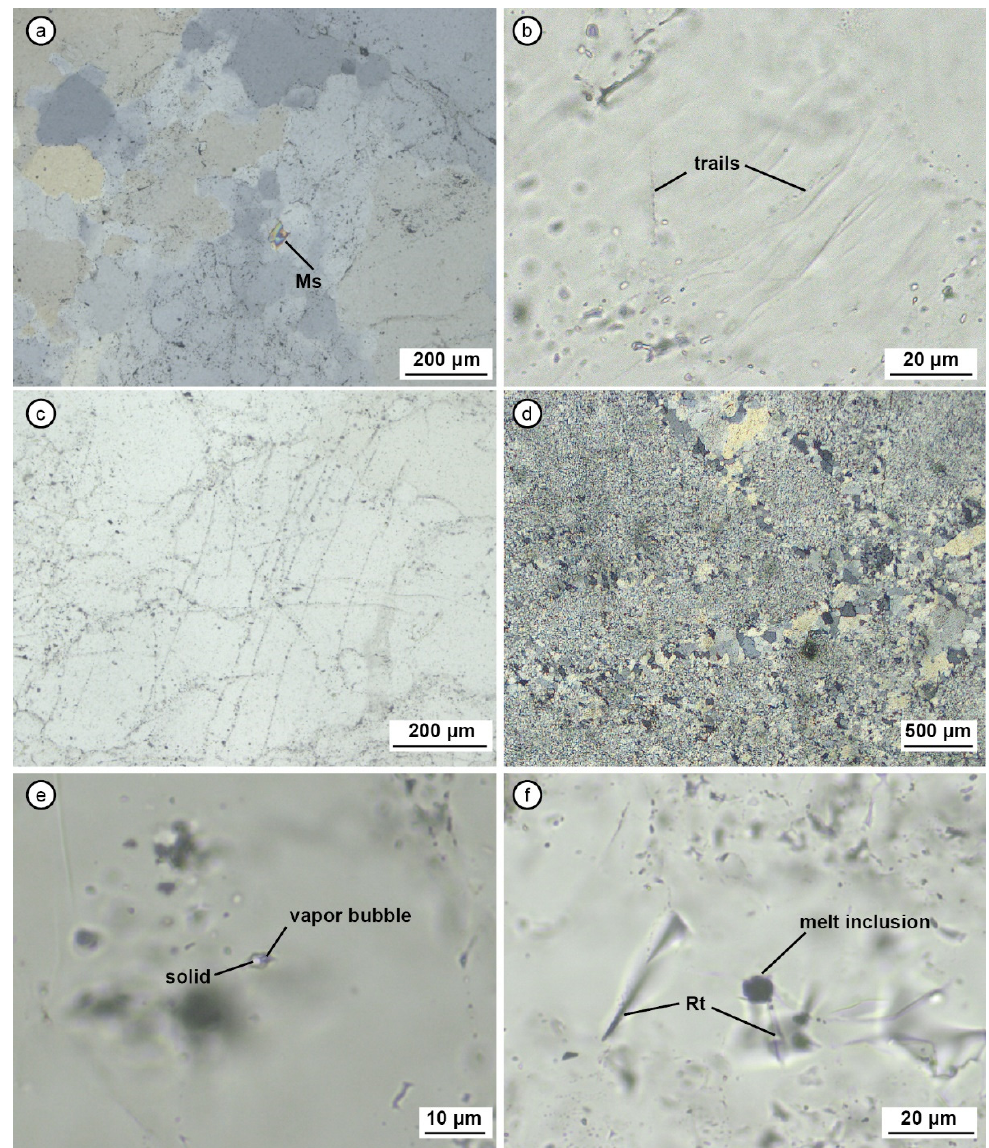
Figure 4. Optical microphotographs of quartz crystals and micro-inclusions; ( a ) Quartz grains with muscovite inclusion from the Fujiashan-II vein exhibiting mortar texture. Cross-polarized light; ( b ) A quartz crystal in quartz from the Fujiashan-I vein forms stripe-like pattern and shows undulatory extinction, indicating deformation alteration. Pseudo-secondary trails are also visible. Plane-polarized light; ( c ) secondary fluid inclusion assemblages crosscutting grain boundaries of quartz from the Fujiashan-II vein indicate metamorphic fluid alteration. Plane-polarized light; ( d ) highly variable grain size of quartz from the Yipanqiu quartz vein. Cross-polarized light; ( e ) fluid inclusion with vapor bubble and solid (presumably salt mineral) in quartz at the Renyou site from the Yipanqiu deposit. Plane-polarized light; ( f ) rutile needles as exsolution product and melt inclusions in quartz at the Zimudong locality from the Yipanqiu deposit. Ms = muscovite, Rt = rutile. The detected mineral inclusions in Fujiashan-II vein quartz are relatively rare, though